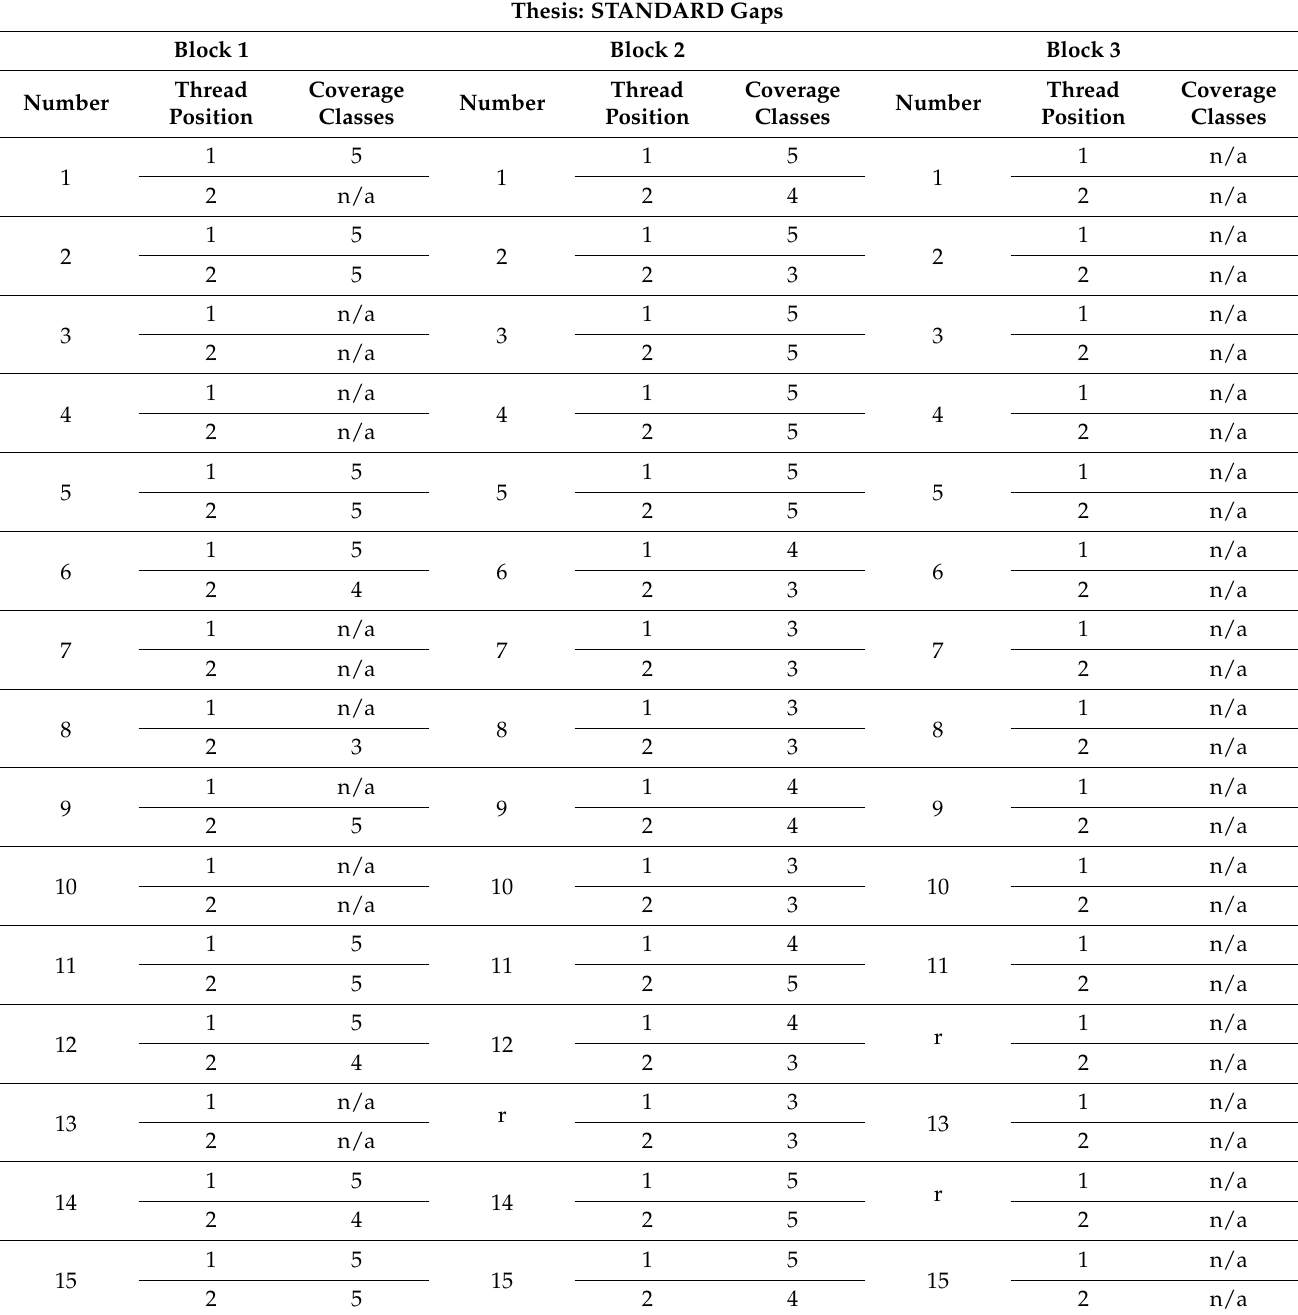
Table 4. Results of the standard test on vine gaps: linkage of WSP coverage classes to each thread